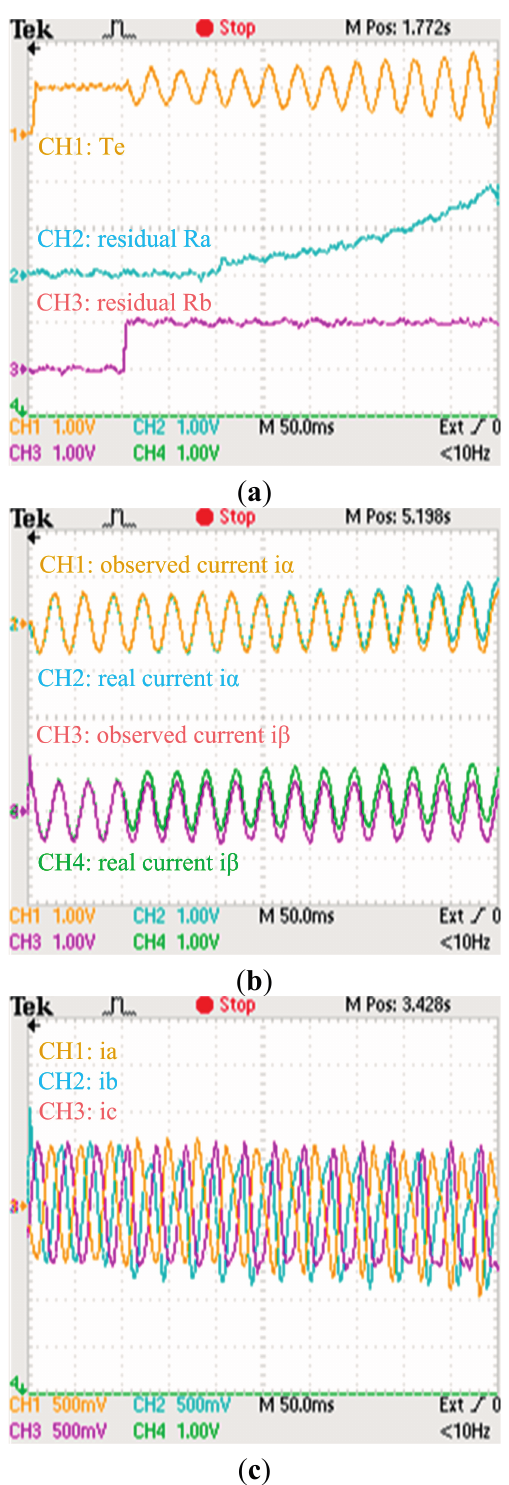
Figure 27. Experimental results when an abrupt offset fault and a slow-variation offset fault are respectively applied to the phase ‘b’ and phase ‘a’ currents sensors: ( a ) Zoom of experimental electromagnetic torque and residual responses; ( b ) Zoom of experimental actual and observing stator currents responses; ( c ) Zoom of experimental phase currents responses. (a) (torque: 500 Nm/div; residual: 30 A/div; t: 50 ms/div); (b) (current: 150 A/div; t: 50 ms/div); (c) (current: 75 A/div; t: 50